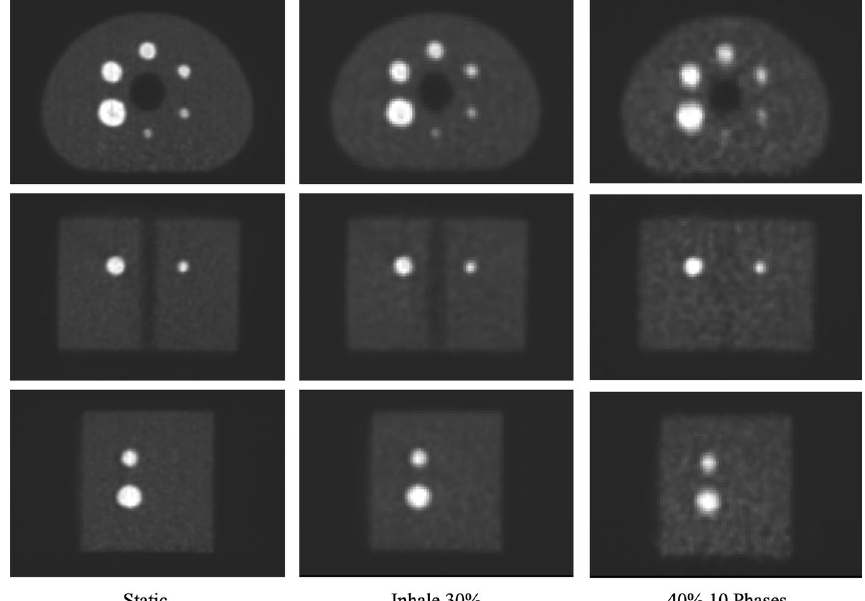
Fig. 9 Coronal, axial and sagittal PET images for reference static protocol, Inhale 30% protocol and 10 Phases protocol of the NEMA